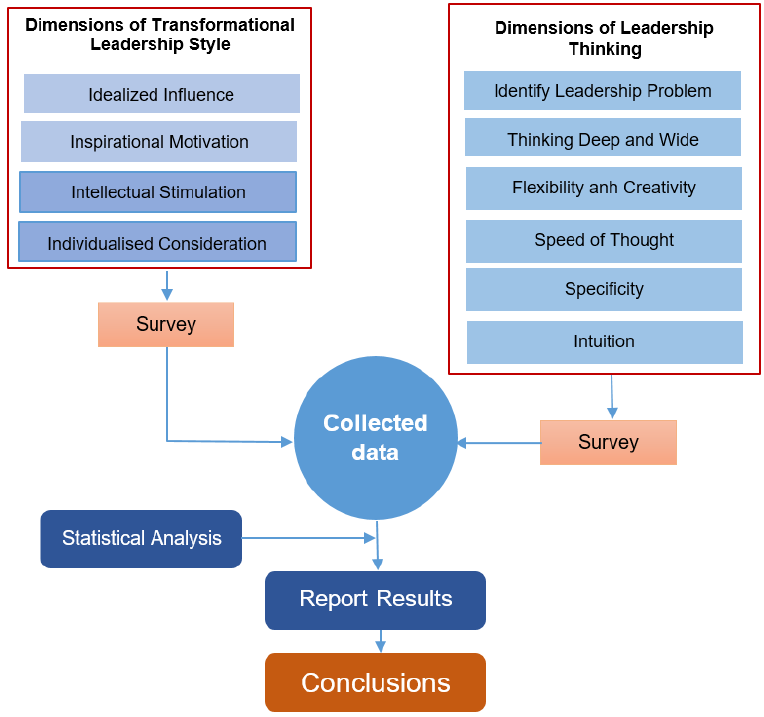
Figure 1. Flowchart of Research